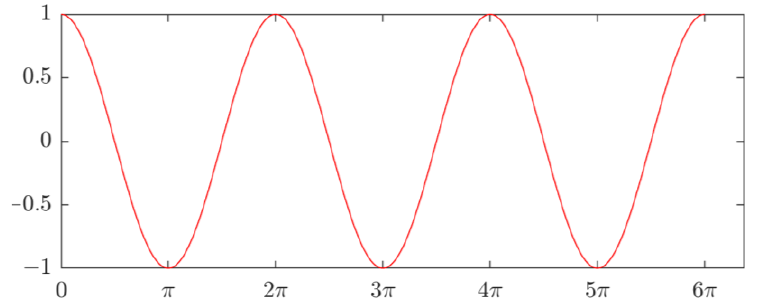
Figure 2. The RT cosine waveform simulation by MATLAB.